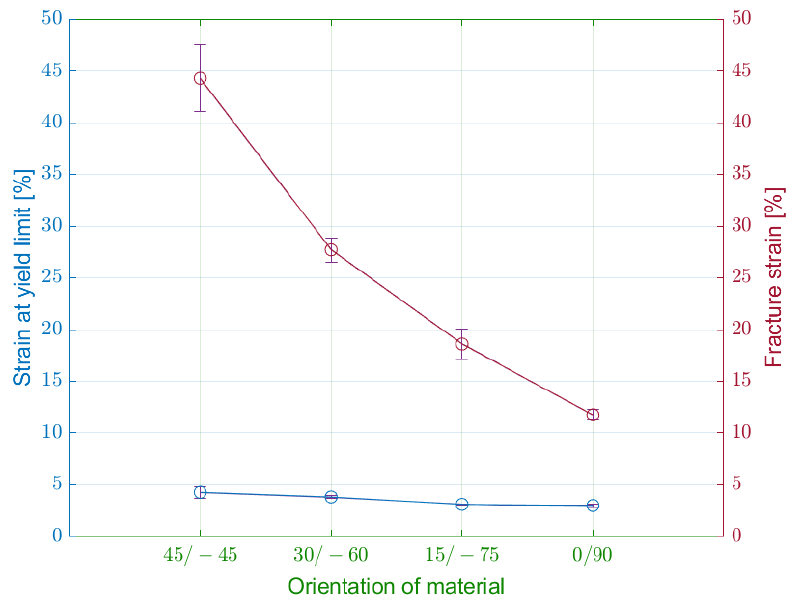
Figure 12 . Influence of infill orientation on strain at the yield limit and fracture strain. Figure 12. Influence of infill orientation on strain at the yield limit and fracture In the case of plastic deformation, the differences between the specimen series are more noticeable. The specimens from the alpha series have the largest plastic region with normal strain at fracture 44.2%. The modification of laminas orientation from 45/ − 45 to 0/90 degrees is connected with a considerable decrease of normal strain. sults in Refs. [31,32]. The comparison showed considerable differences, since alpha speci- mens have two times larger strain values. The explanation could be the difference between the compared specimens specified in Section 4.1.1. On the other hand, the material data given in Table 1 show strain at the fracture of almost 60%, which is close to the measured values for the alpha specimens. The effects of laminas orientation are also confirmed by images from the failure re- gion of the selected two series of specimens in Figure 13. The crack path is different in both cases. In the case of 0/90 lamina orientation, the crack path is perpendicular to the direction of the loading axis (Figure 13a). In case of 45/ − 45 infill pattern, the vast majority of the crack path is in the 45/ − 45 degree to the loading axis (Figure 13b). The sections along the filament are interrupted by very short perpendiculars intersecting this interfilamen- tous fracture. The presence of walls around the specimen circumference affected the tra- jectory of the crack in the edge area since the wall filament orientation is parallel to the loading axis and also different to infill pattern orientation. In all series, the crack trajectory depends on the infill pattern orientation to loading.